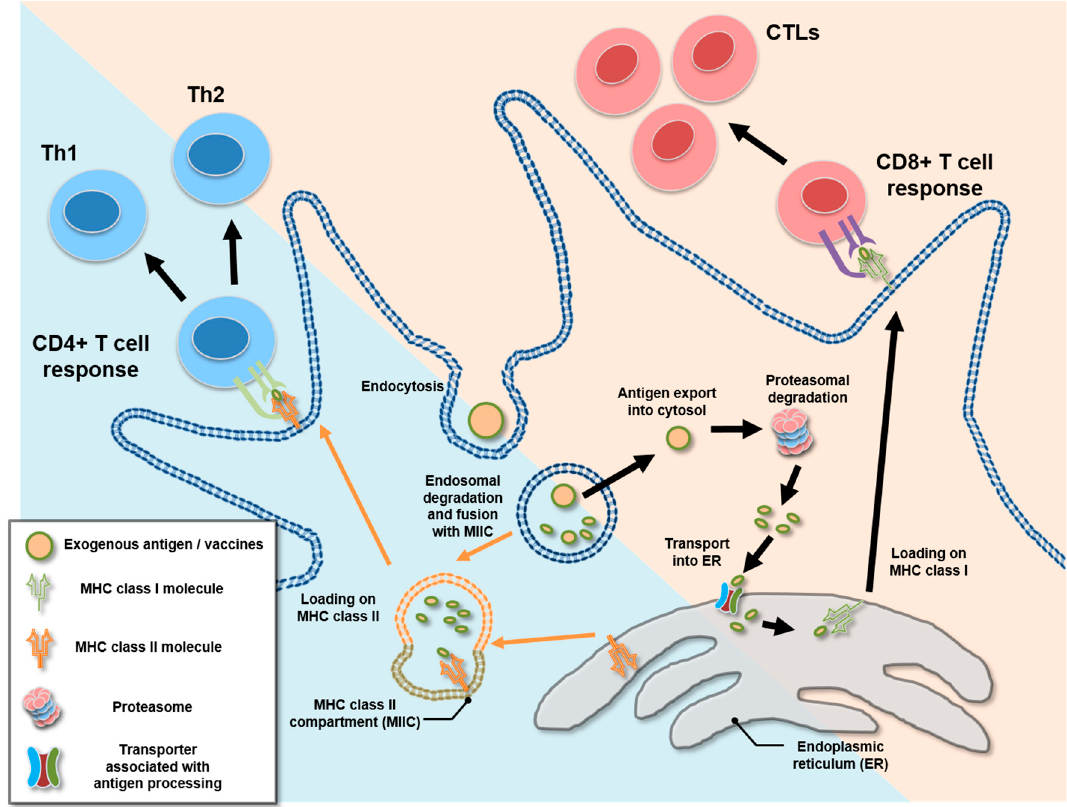
Figure 1. Schematic diagram for the presentation of an exogenous antigen in DCs. The exogenous antigen, in a general process, is presented by an MHC class II loading pathway (cyan color background). After endocytosis, the endosome-containing antigen goes through the process of maturation, including acidification. Then, MHC class II-containing intracellular vesicles called the MHC class II compartment fuses with the endosome. Through this process, the antigen degraded by proteolytic enzymes and loaded onto MHC class II leads to the presentation to CD4 + T cells. Alternatively, an exogenous antigen could be presented with MHC class I via cross-presentation (yellow background). After endocytosis, the antigen could be exported into cytosol via various pathways (see details in Figure 2). The exported antigens (epitopes) degraded by proteasome are transported to endoplasmic reticulum via transporter associated with antigen processing (TAP). Then, the epitope is loaded onto the pocket of MHC class I resulting in recognition by and activation of CD8 + T cells.